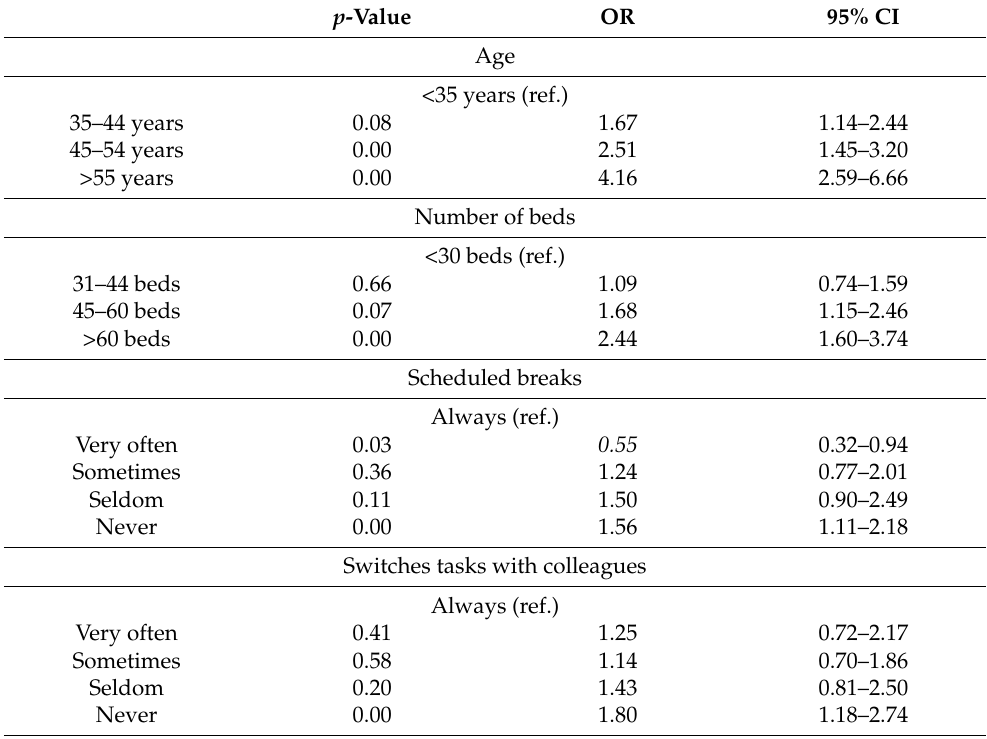
Table 4. Explanatory model of chronic pain. Binary logistic